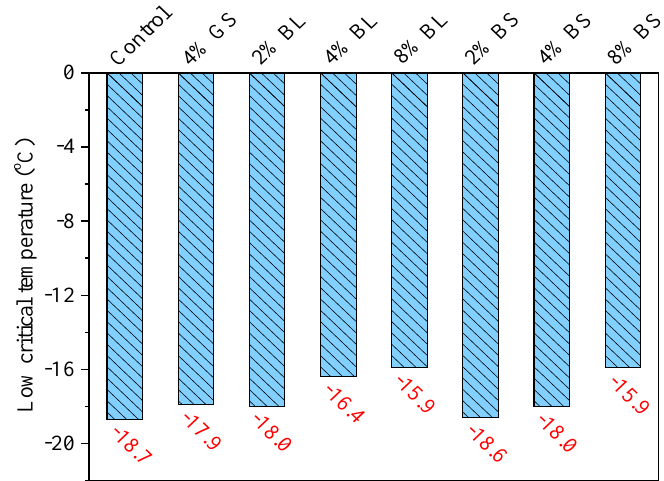
Figure 6. Low critical temperatures of control, graphite modified and bio-char modified asphalts.